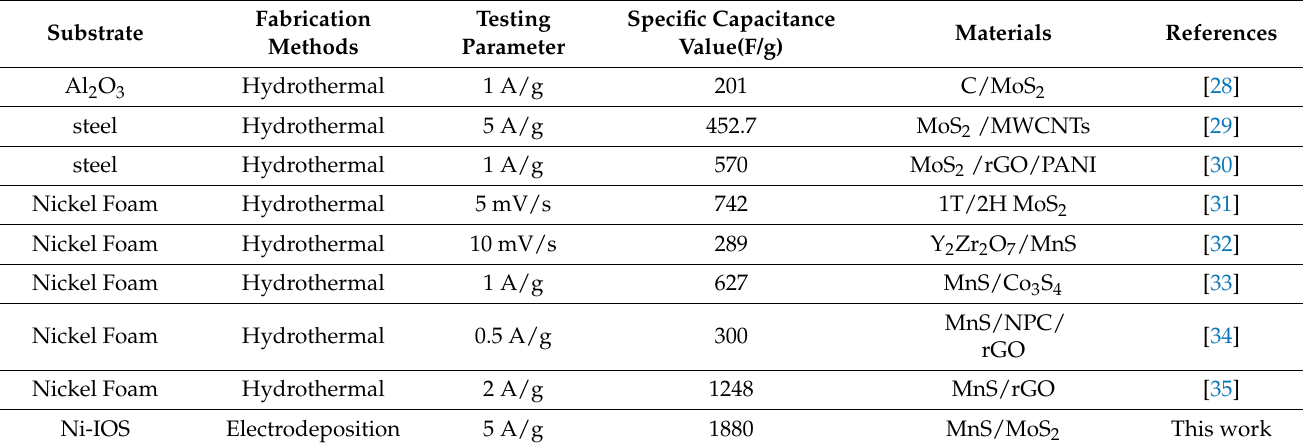
Table 2. The specific capacitance value of the sample by CV with a scan rate of 10 mV/s and 10 min deposition